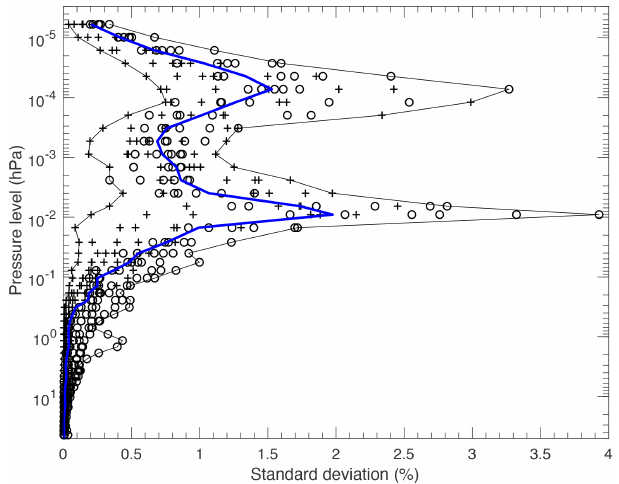
Figure 9. Standard deviation (SD) of the Southern Hemisphere (SH) polar-cap monthly ozone anomalies from a 10-member en- semble of SD-WACCM-D APEEP REF simulations, relative to the ensemble mean. Plus signs ( + ) indicate SDs for the individ- ual months of January, February, March, October, November, and December (summer); circles are for individual months from April to September (winter); black lines are the minimum and maximum SD at each pressure level; and the blue thick line is the median of all monthly